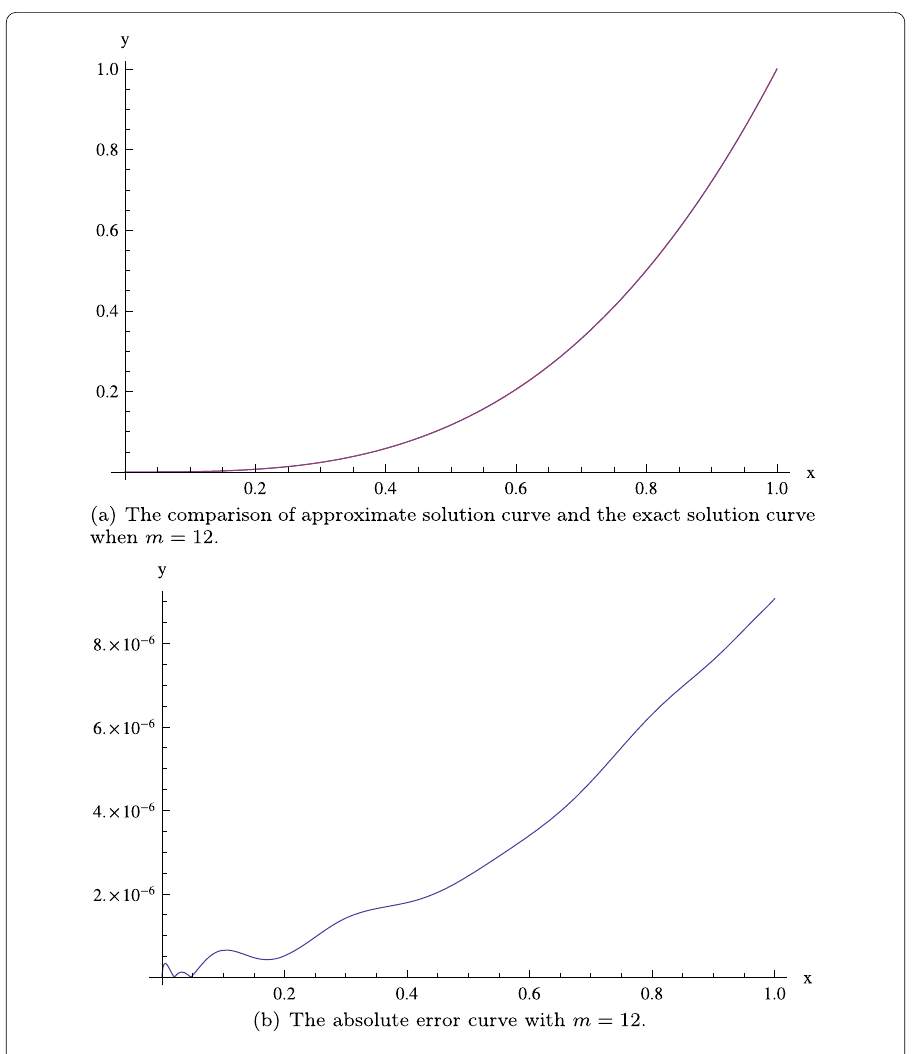
Figure 7 The comparison of the approximate solution and the exact solution when m = 12